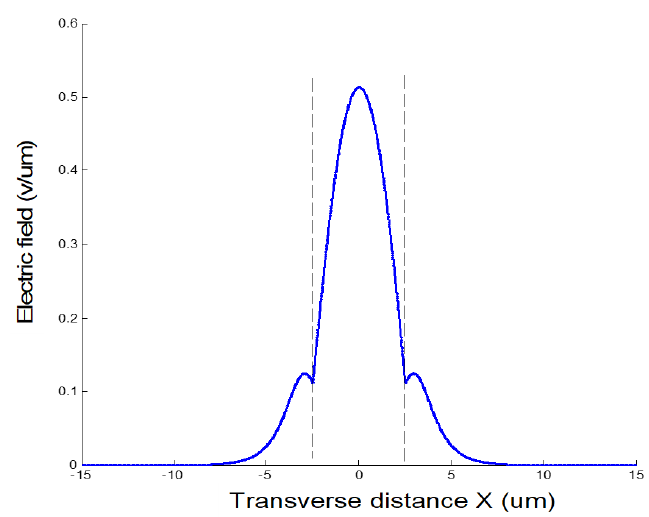
Figure 11. The electric field distribution with d f = 5 μ m and β = 1.5648.